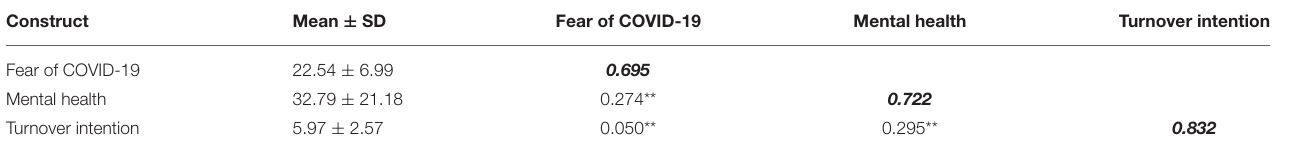
TABLE 5 | Correlations of constructs and AVE values.